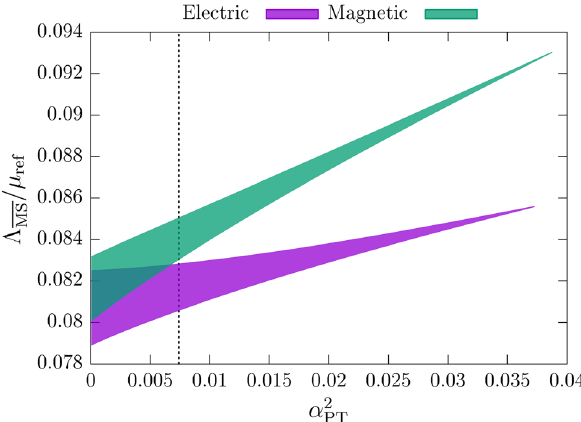
/μ φ (α ) (see Fig. 3 The ratio (cid:3) ref estimated from the function GF PT MS Eq. (3.30)) as a function of the matching scale with perturbation theory / 4 π ). At α ∼ 0 . 08 (our most perturbative (represented by α PT = ¯ g 2 PT PT data point, indicated by a vertical line data point) the NNLO predictions using the electric and magnetic schemes disagree by ∼ 2 .